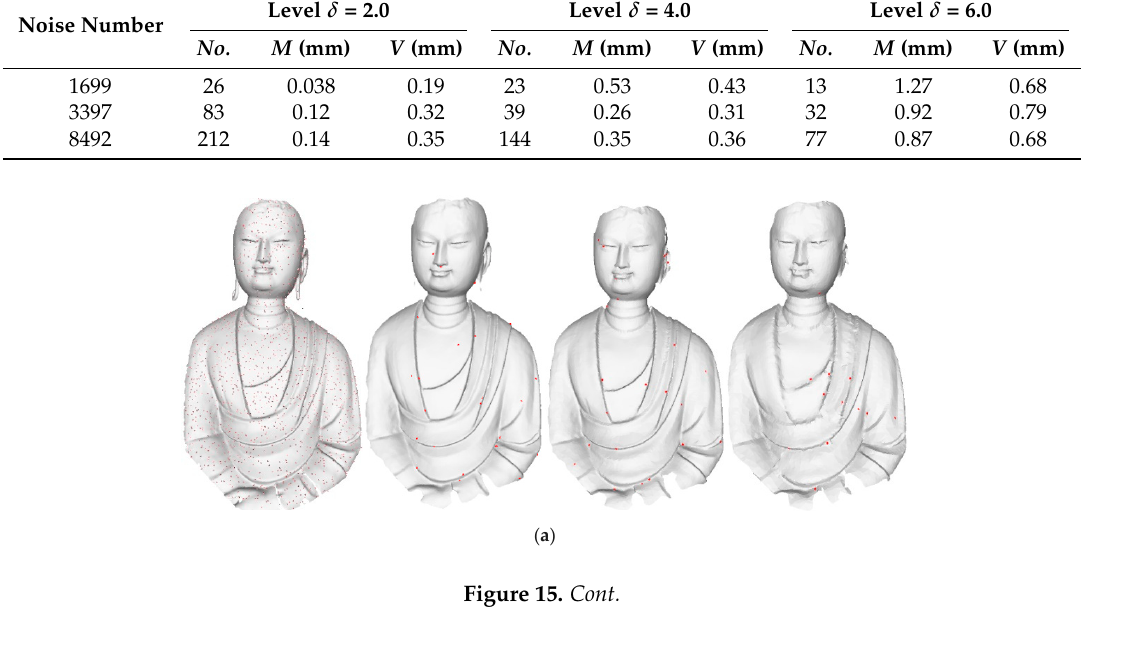
Table 3. Quantitative evaluation of remaining noise.